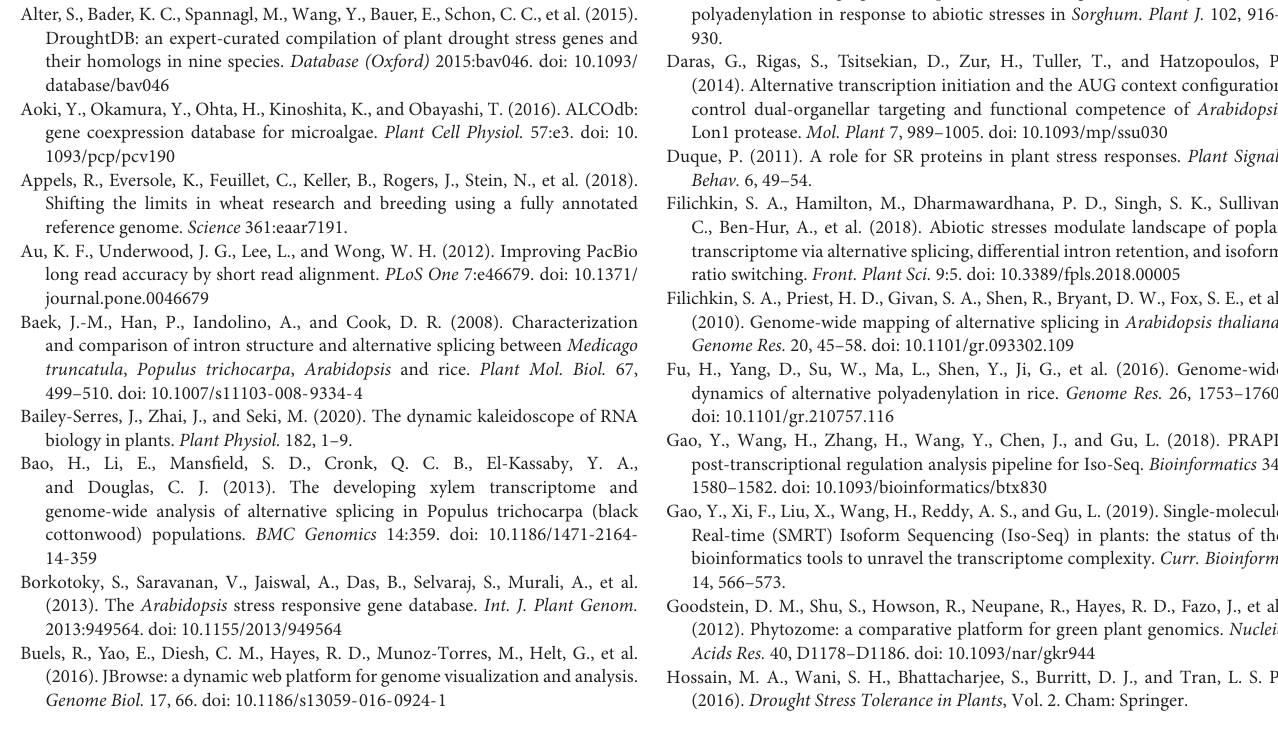
Supplementary Figure 1 | Genome-wide distribution of H3K9ac enrichment in Populus trichocarpa under drought stress, which is presented in nine circles from 1 (innermost circle) to 9 (outermost circle). The inner-circle 1 represents gene density. Circle 2 shows H3K9ac enrichment distribution after 7 days drought. The